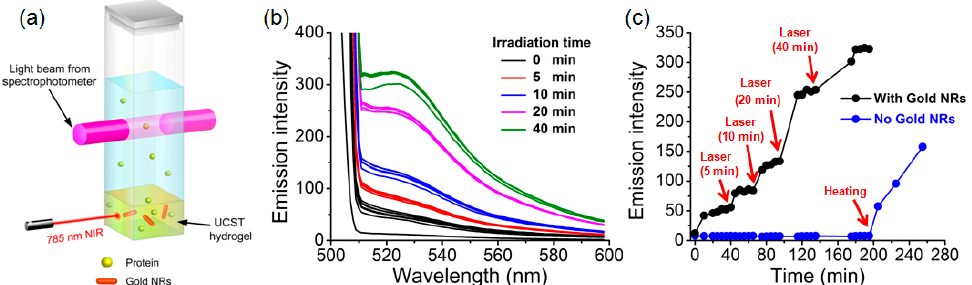
Figure 5. ( a ) Setup used to detect protein diffusing from the hydrogel into the aqueous solution after 785 nm laser irradiation. ( b ) Fluorescence emission spectra of the protein recorded after exposing the hydrogel to laser light (1 W) for a certain amount of time (indicated). ( c ) Plots of the fluorescence emission intensity vs. NIR irradiation time, showing a temporal control of the protein release by turning the NIR laser on and off.